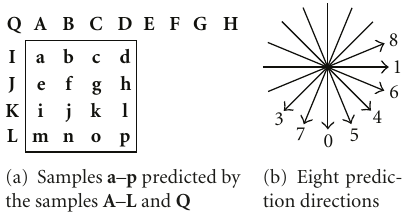
Figure 1: Intra 4 × 4 coding